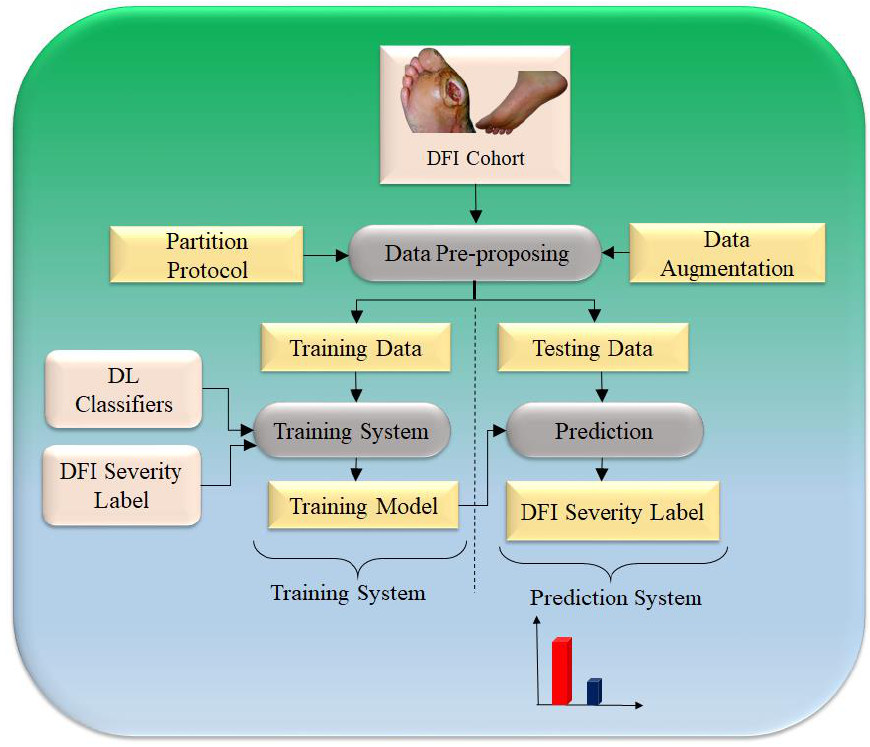
Figure 12. CNN-based model for DFI predication [51].